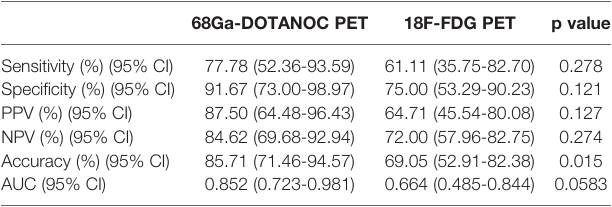
TABLE 4 | Sensitivity, speci fi city, positive and negative predictive value, accuracy and AUC for the prediction of LN group metastasis by 68Ga-DOTANOC and 18F-FDG PET through semiquantitative